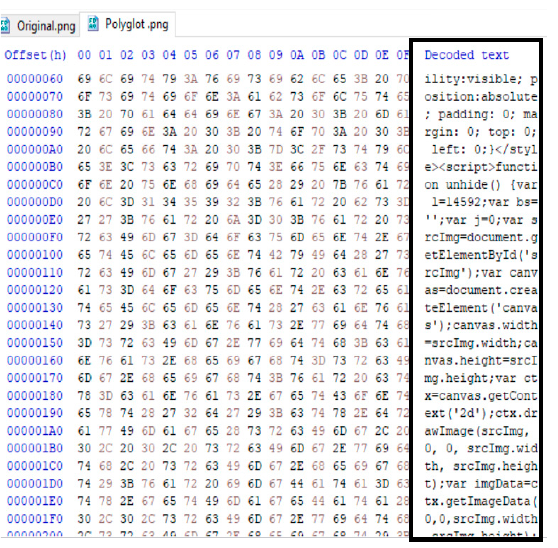
Figure 11. The original image file structure is in hexadecimal view.